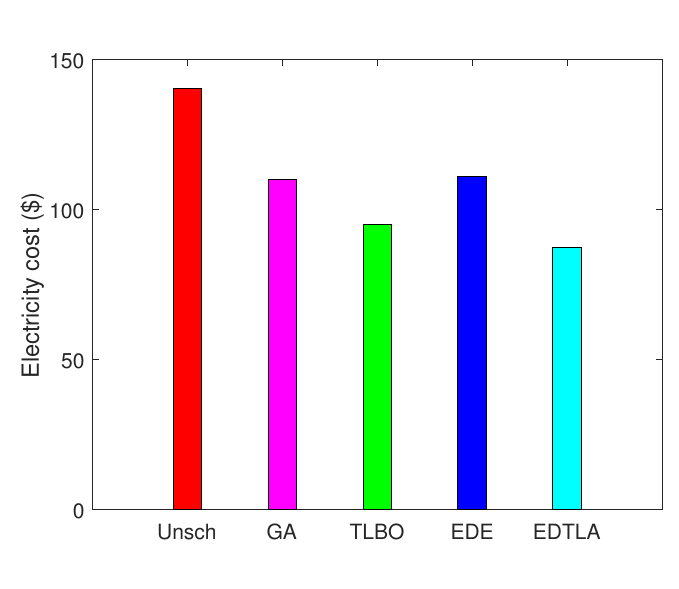
Figure 15. Daily electricity